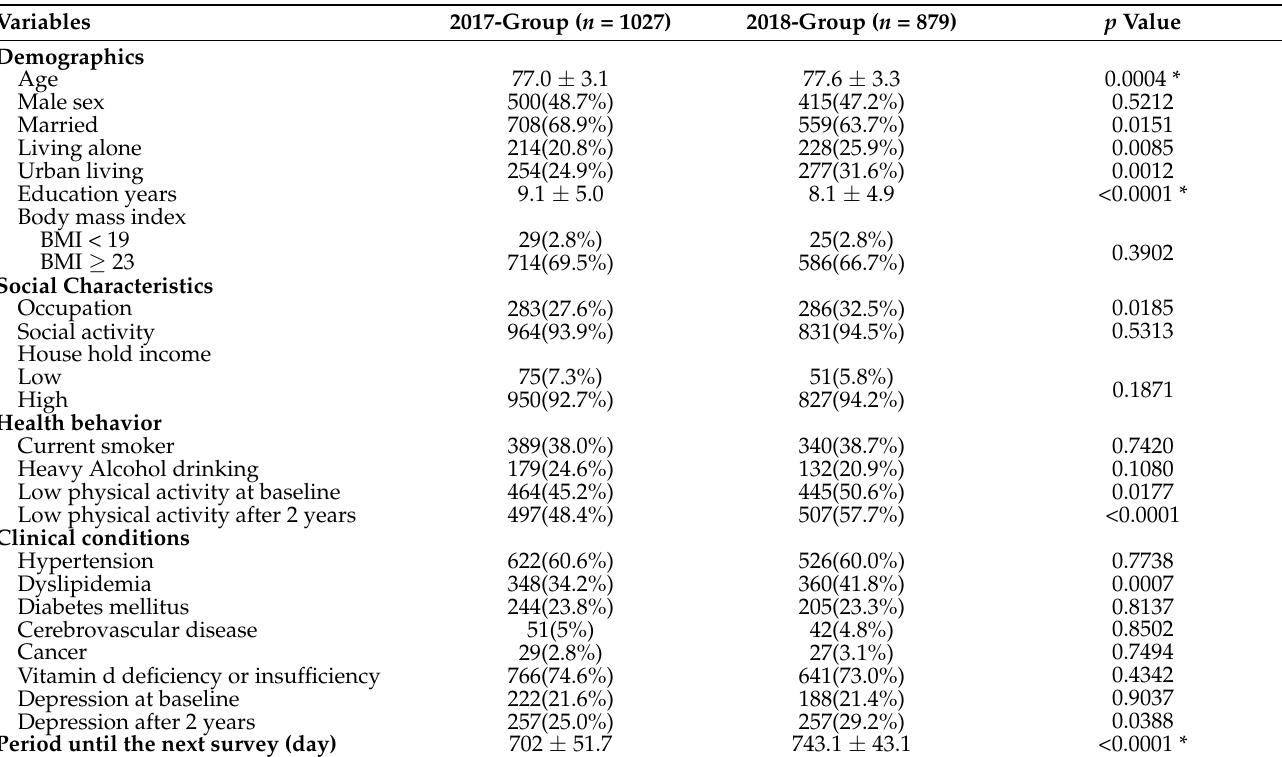
Table 1. Baseline characteristics of the study subjects according to intergroup